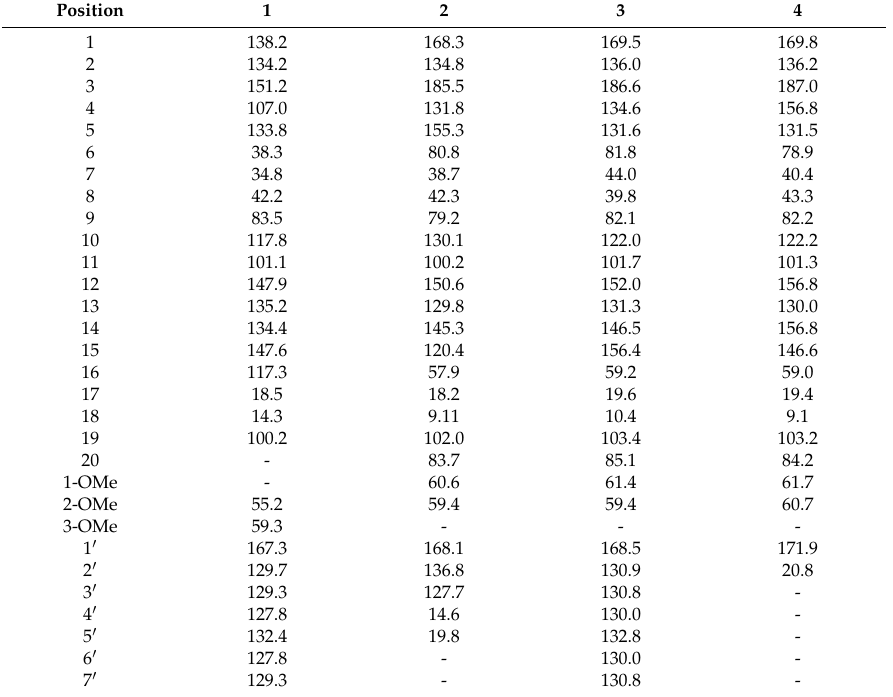
Figure 2. Key HMBC (H → C) correlations and selected NOESY (H ↔ H) correlations of compounds 1 – 4 . Table 2. 13 C-NMR data of compounds 1 – 4 (CD 3 OD, δ in ppm, J /Hz, 150 MHz).